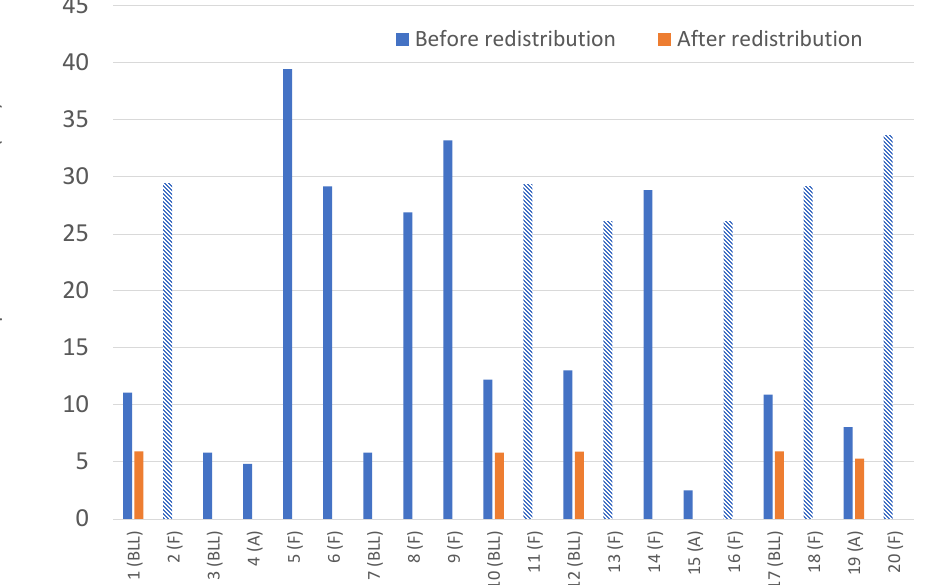
Figure 5. Framework evaluation for Scenario A. Each bar shows the execution time per 100 iterations of each application. Applications with striped bars are applications that create interference. Applications with two bars exhibit change in the execution time due to interferences.